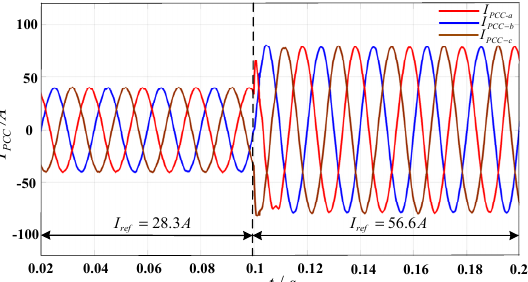
Figure 18. Simulation result of current waveform at PCC after reshaping when the reference current of TFSCI changes.